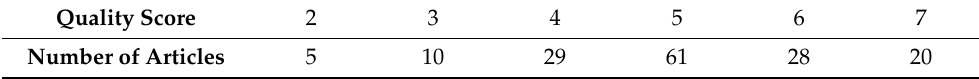
Table 3. Frequency of quality scores for all 153 included papers. Quality was assessed using quality assessment forms (Tables S1 and S2).